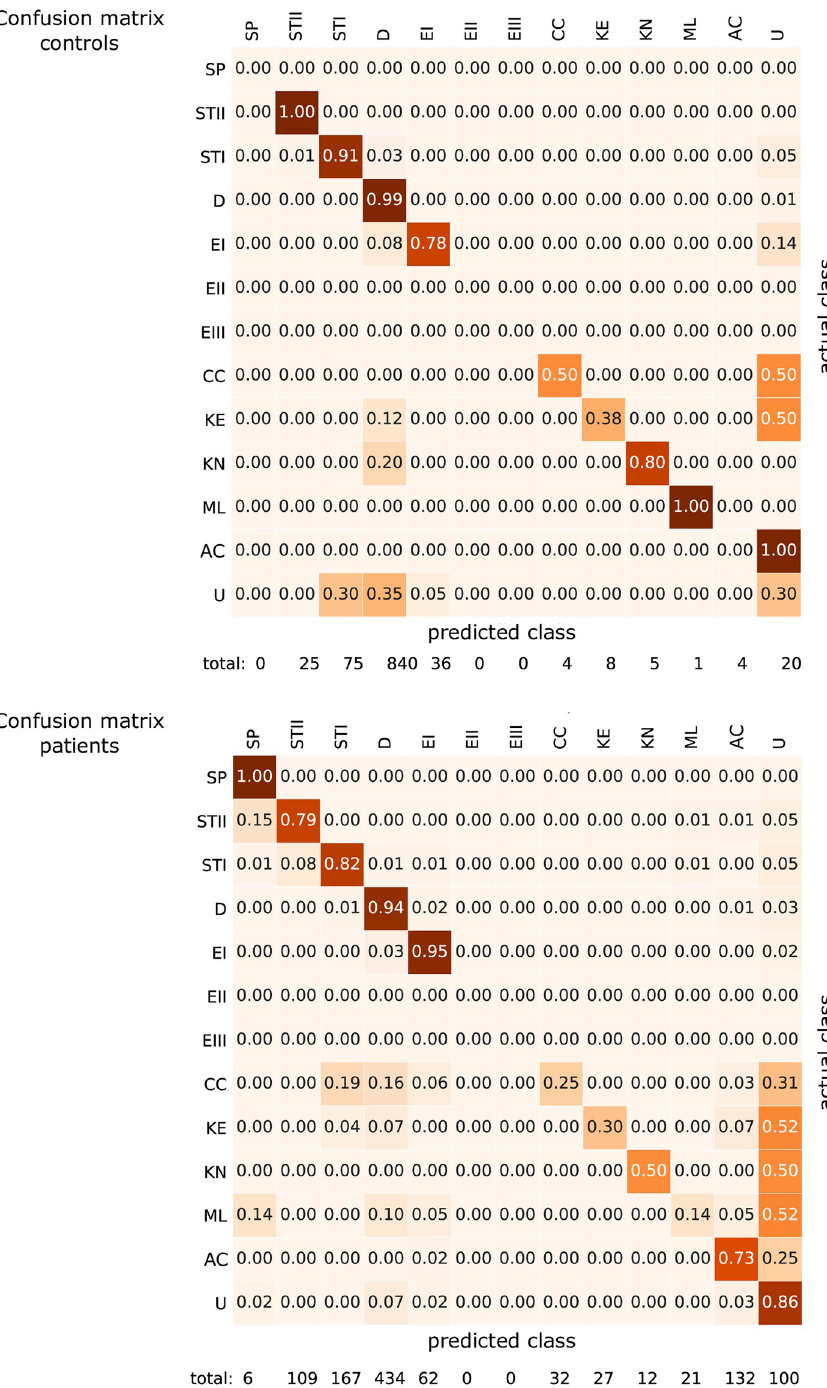
Fig 6. Confusion matrices for healthy controls and patients with hereditary spherocytosis comparing “predicted” (automated recognition) and “actual” (manually classified) shape classes. 2000 cells from 5 healthy subjects and 5 patients (10 donors × 200 cells) that were not included in the training process were randomly picked and the automated predictions of the dual-stage neural network was manually verified by observation of the corresponding 3D reconstruction. The confusion matrix shows the agreement percentage between the automated cell shape recognition (columns/predicted class) and manual inspection (rows/actual class). Since SDE shapes do not owe to a specific class, the accuracy of the predictions was judged by considering the interval between the score of two perfect shapes, which corresponds to ± 0.17. For instance, a discocyte (D) has score 0 and we considered correctly predicted any assigned value between 0 ± 0.17. The total number of cells encountered in each shape class during the manual verification